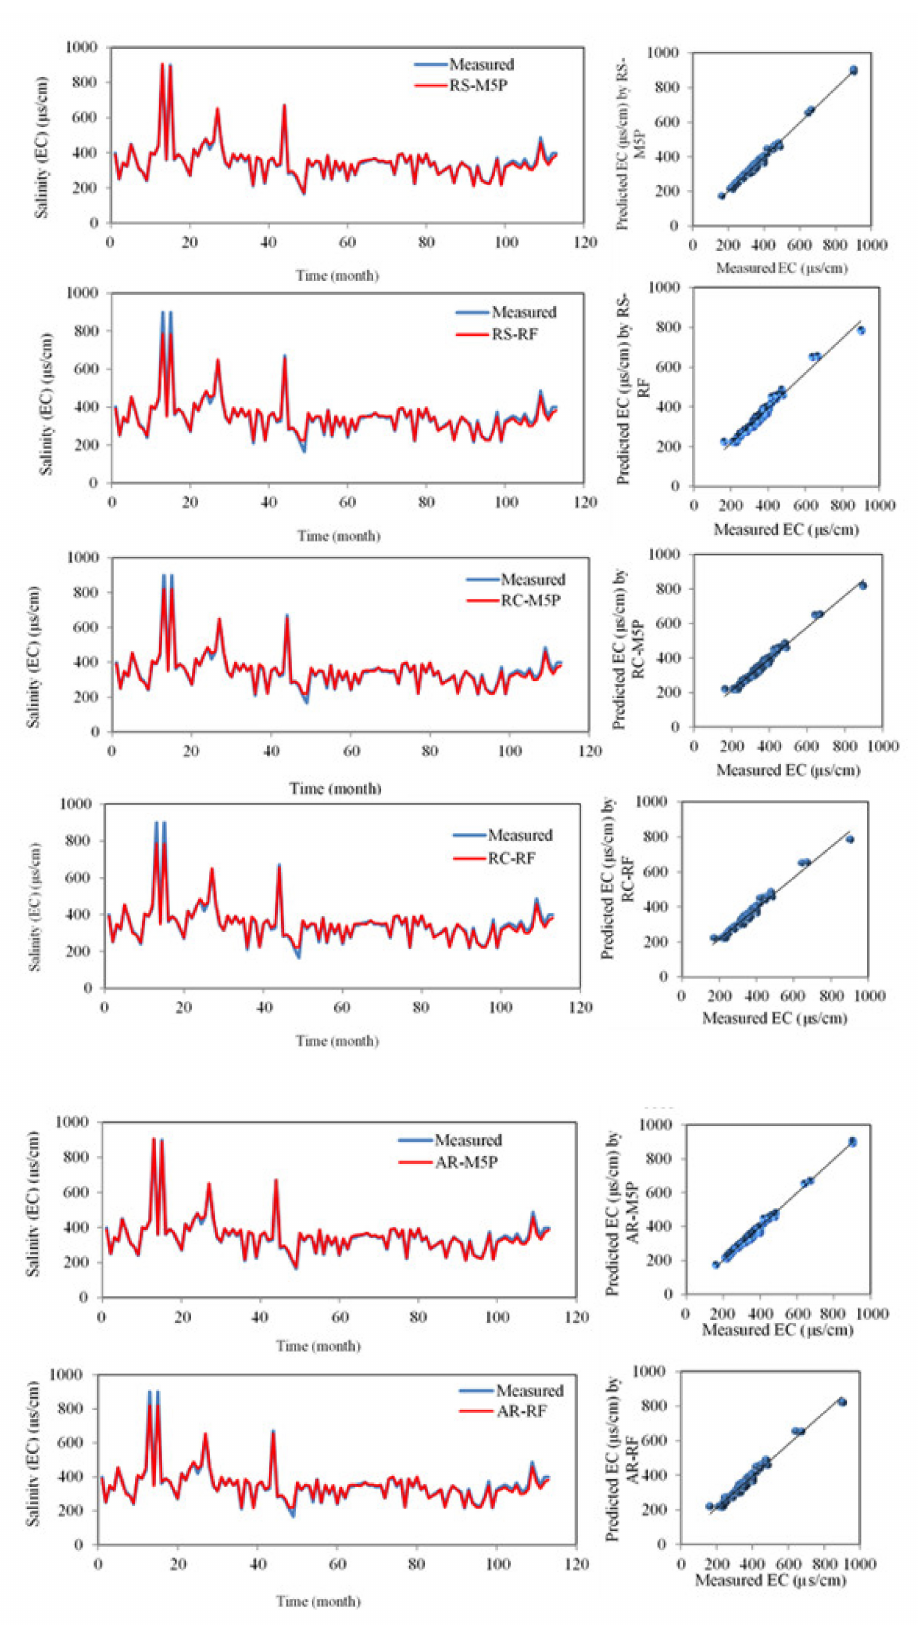
Figure 4. Time-variation and scatter plots of observed and predicted EC in the testing